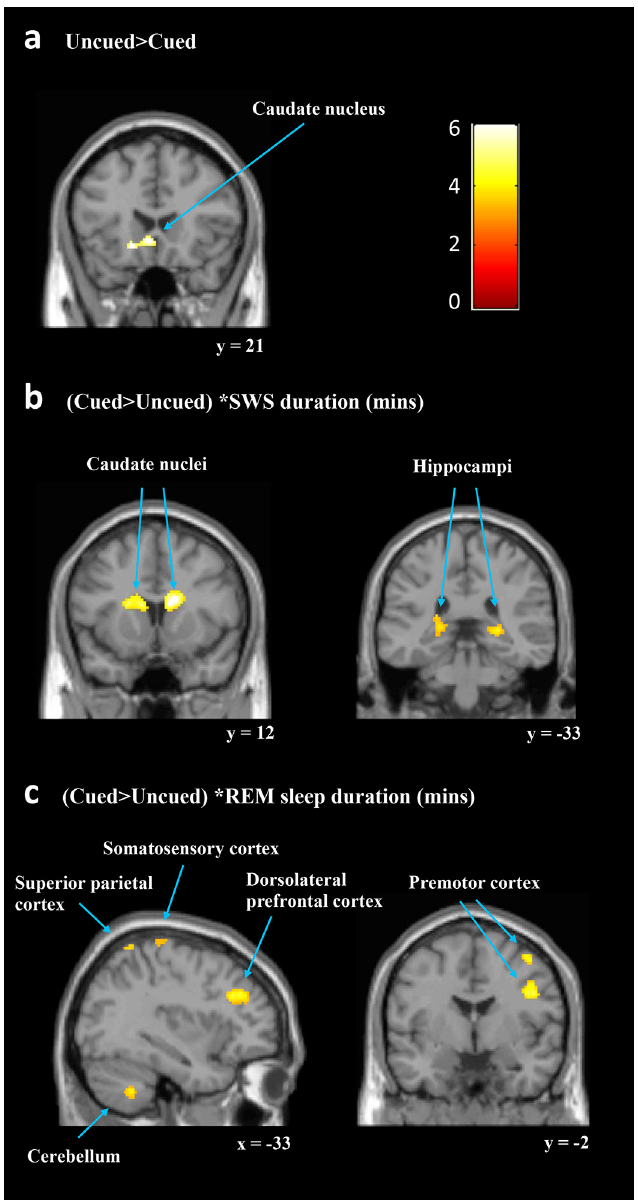
Fig 3. Changes in brain activity after targeted-memory reactivation. (a) The basic comparison between cued and uncued showed reduced activity in left caudate ( − 20, 24, − 10) for the cued sequence. (b) SWS was associated with enhanced activation in bilateral caudate (16, 8, 20 and − 12, 20, 12), and bilateral hippocampi (26, − 34, 2 and − 22, − 34, 6) for the cued sequence relative to the uncued. (b) REM sleep was associated with cueing related activity enhancement in left cerebellum ( − 32, − 54, − 44 and 20 − 72, − 26), left superior parietal cortex ( − 28, − 56, 68 and 22, − 54, 38), left sensorimotor cortex (SMC) ( − 40, − 32, 68), left dorsolateral prefrontal cortex (dlPFC) ( − 30, 34, 28) and right premotor cortex (PMC) (42, − 2, 32 and 42, − 2, 58). These findings were whole brain corrected ( p < 0.05) and displayed as sagittal and coronal projections superimposed on a standard Montreal Neurological Institute (MNI) brain. Colour bar indicates t-values. Anatomical labelling based on peak z-score location. for the cued sequence in a number of motor regions, including bilateral cerebellum, right pre- motor cortex (PMC), and left SMC (Fig 3C, Table 3). Additionally, left dorsolateral prefrontal